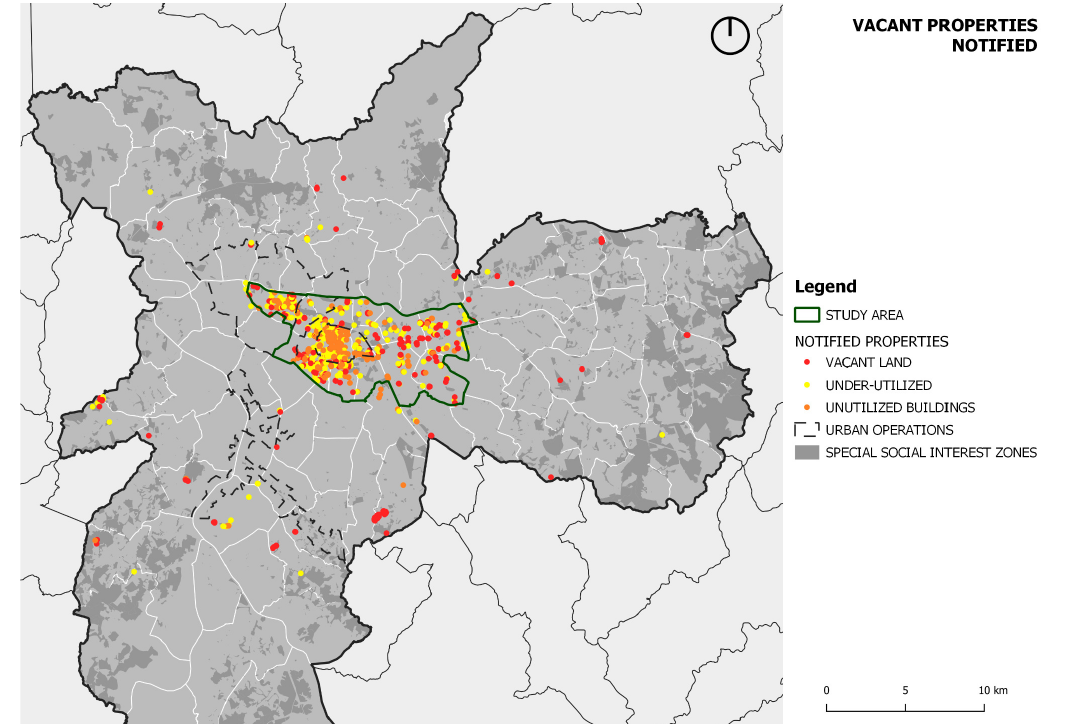
Figure 1. Distribution of vacant properties notified for PEUC purposes in the city of São Paulo between 2014 and 2019. Source: City of São Paulo